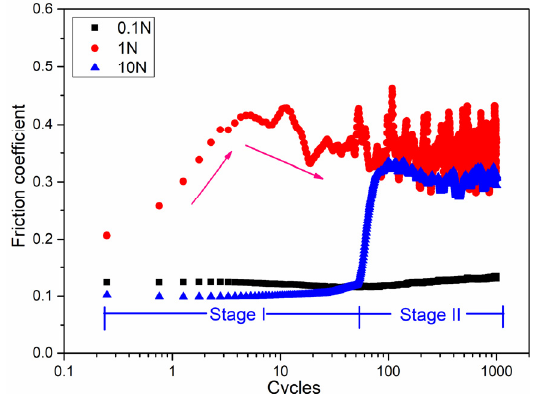
Figure 2. Friction coefficient of pure magnesium under different loads during reciprocating sliding friction tests.